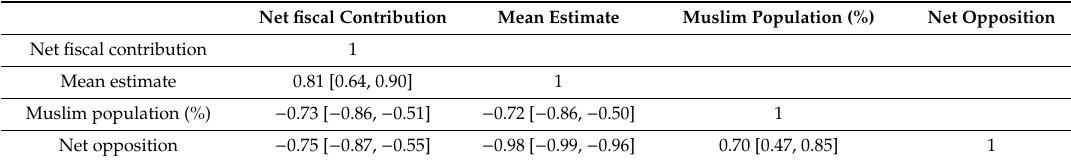
Table 3. Correlation matrix for the primary aggregate-level variables. ‘Net fiscal contribution’ refers to each origin country group’s actual net fiscal contribution in Denmark in 2014, according to the Danish Ministry of Finance. ‘Mean estimate’ refers to our respondents’ mean estimate of each group’s net fiscal contribution. ‘Net opposition’ refers to our respondents’ net opposition to immigrants from each origin country. ‘Muslim population (%)’ refers to the percentage of Muslims in the home country.